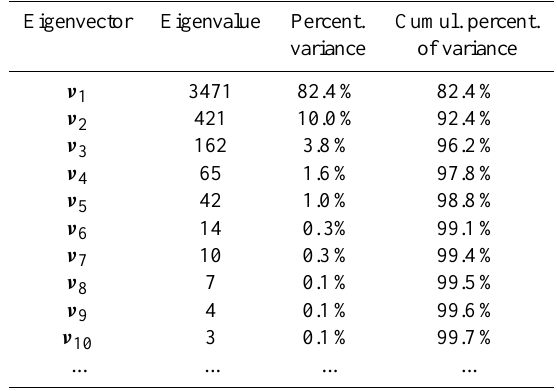
Table 1. Eigenvalues and (cumulative) percentage of variance for first 10